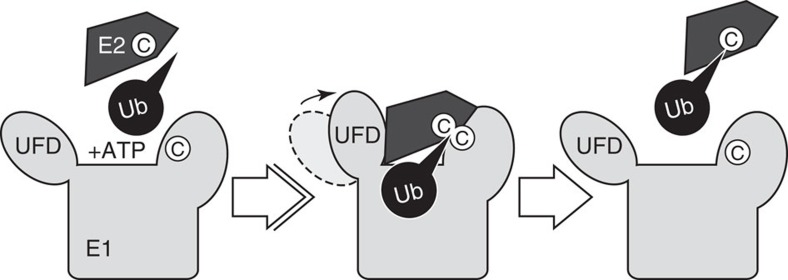
Ubiquitin (Ub) conjugating enzyme (E2) activation by Ub-activating enzyme (E1).Conformational changes are crucial to E1 activity including rotation (closed arrow) of the UFD, which is required to efficiently position E2 for ubiquitin (Ub) thioester (E2∼Ub) formation. Active-site cysteine residues (C, circled) move into proximity for trans-thiolation of Ub from E1 to E2.